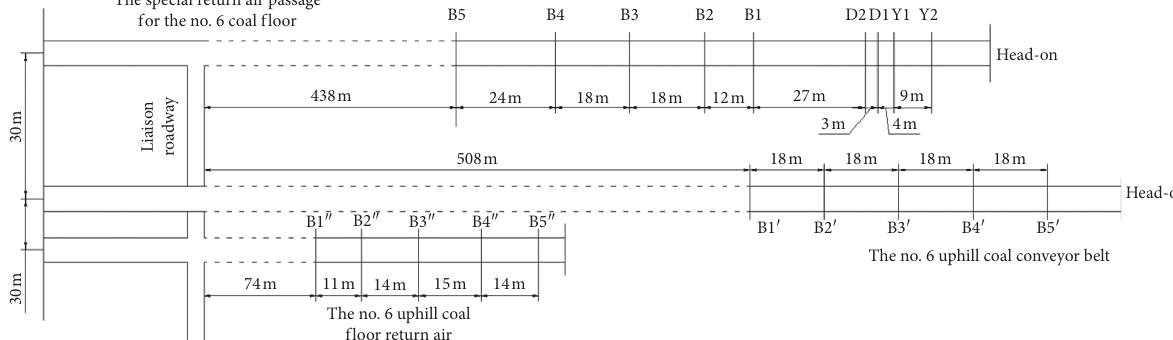
Figure 19: Schematic diagram of observation station arrangement.